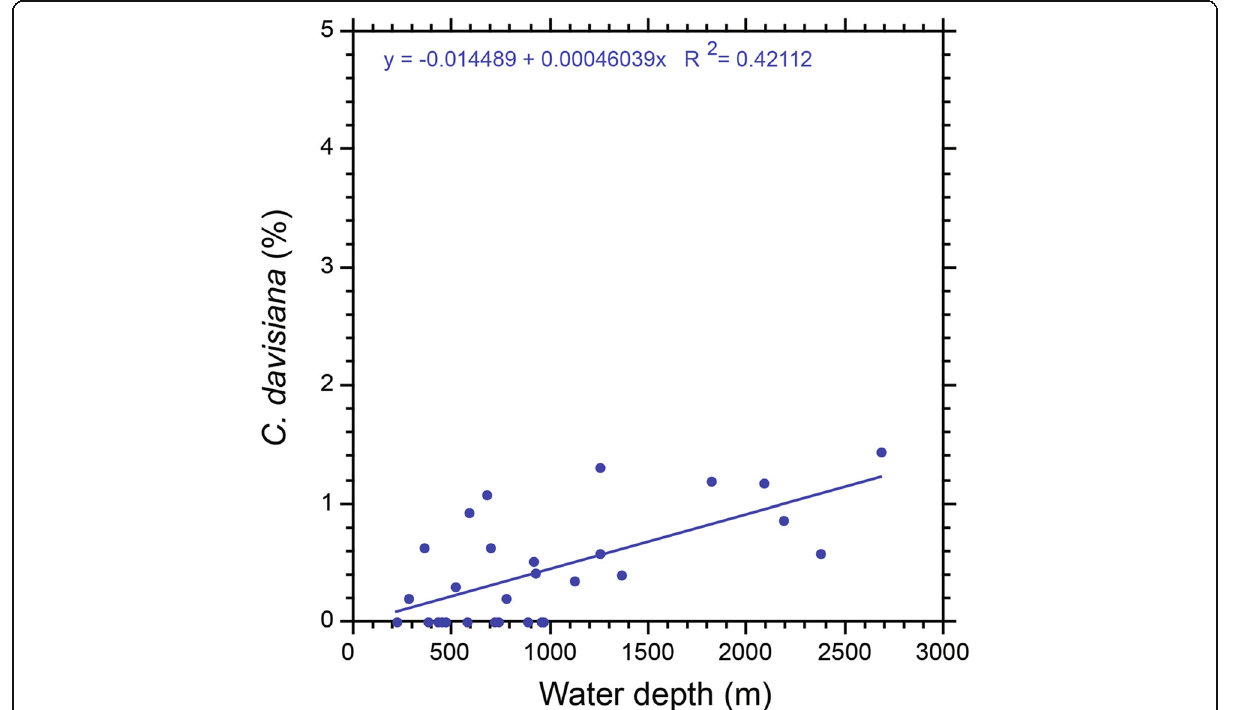
Fig. 10 Current vertical distribution of C . davisiana in the ECS based on the dataset of Matsuzaki and Itaki